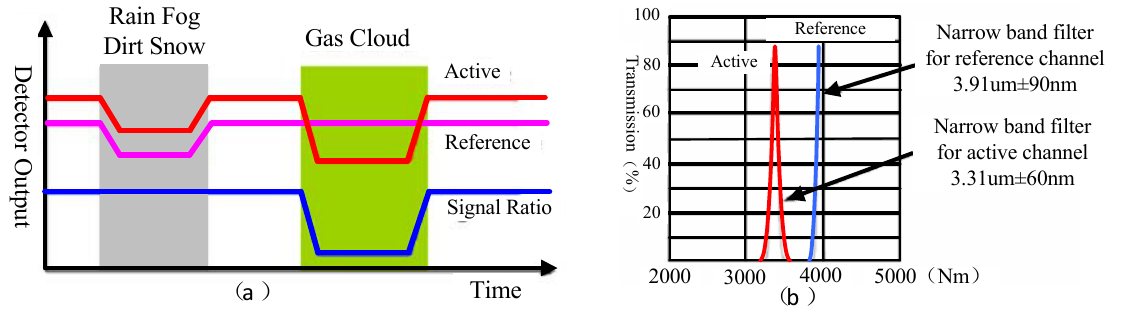
Figure 3. ( a ) The relationship of response channel, reference channel output signal and the input signal; ( b ) Optical performance of narrowband